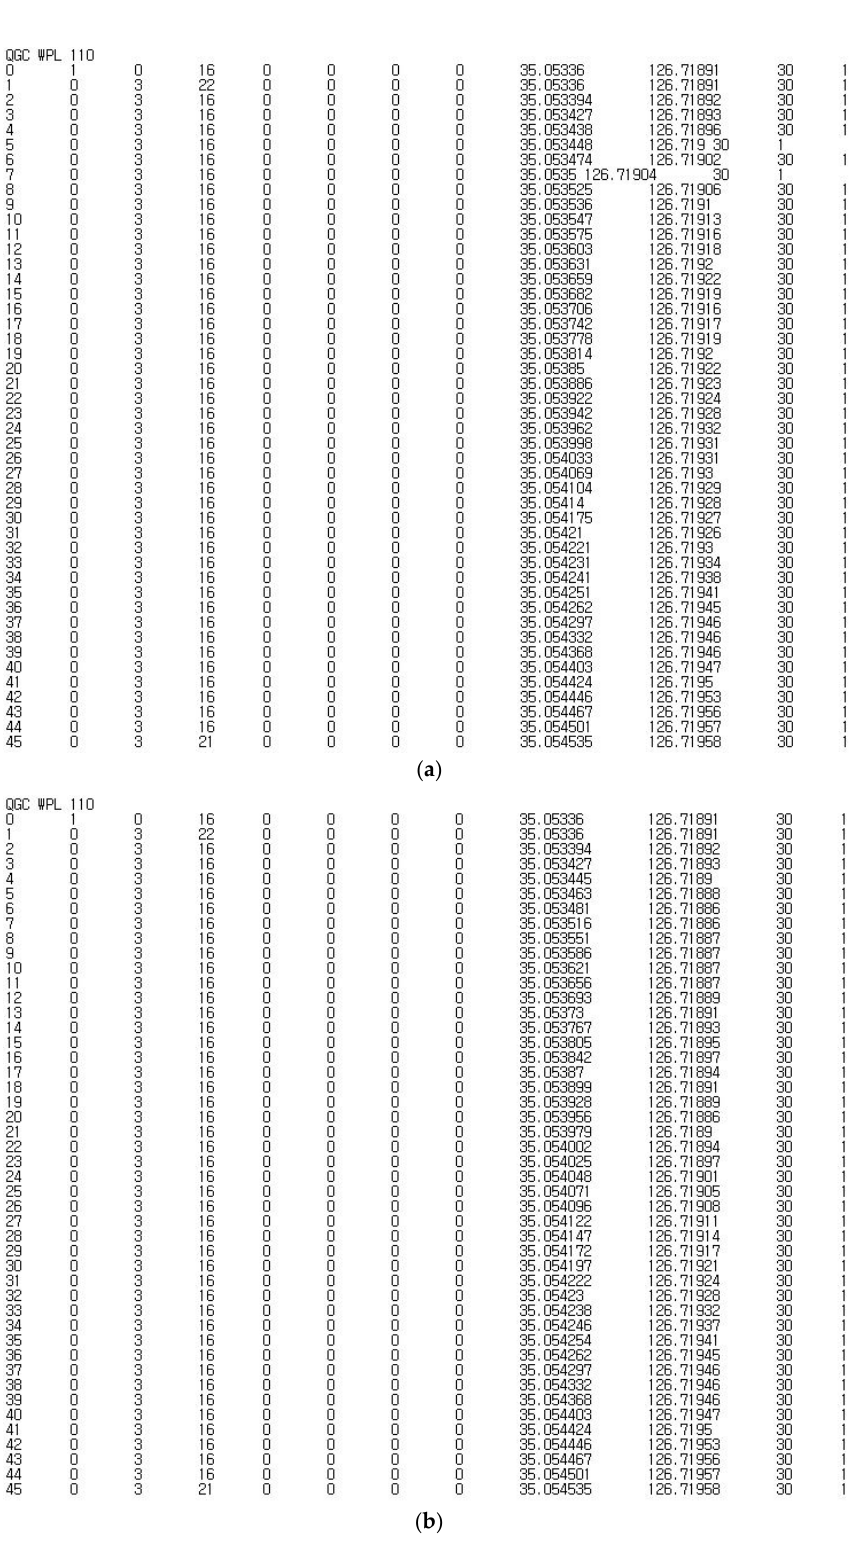
Figure A2. Waypoint list of SPP and EEPP trajectories: ( a ) SPP; ( b ) EEPP.